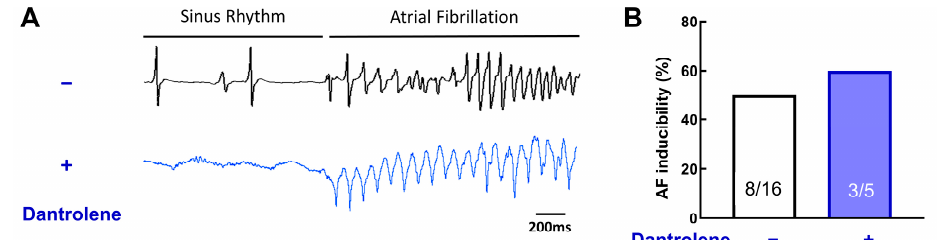
Figure 8. RyR stabilization does not prevent acute AF episodes. ( A ) Example of ECG traces, with or without Dantrolene, a RyR inhibitor. ( B ) Inducibility of AF for each group. Dantrolene does not change AF vulnerability. N = 16 and 5, chi-square test.